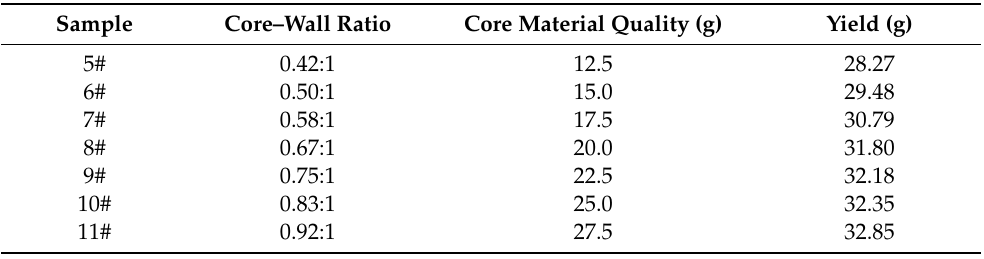
Table 7. Yield results of microcapsules in the single factor experiment.